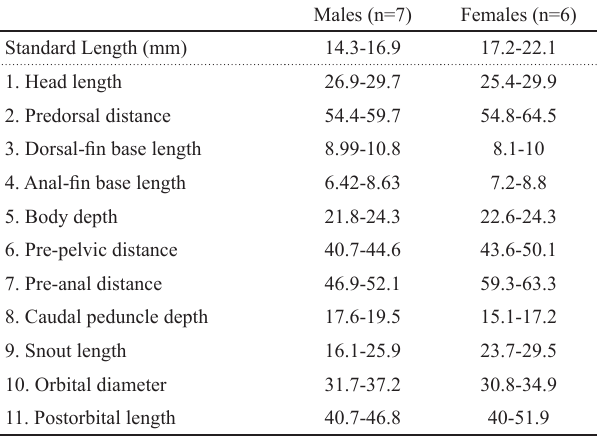
Tab. 1. Morphometrics of collected specimens of Poecilia reticulata from lower Paraguay River basin, Formosa, Argentina. Values 1-8 are percentages of the standard length and values 9-11 are percentages of head length.